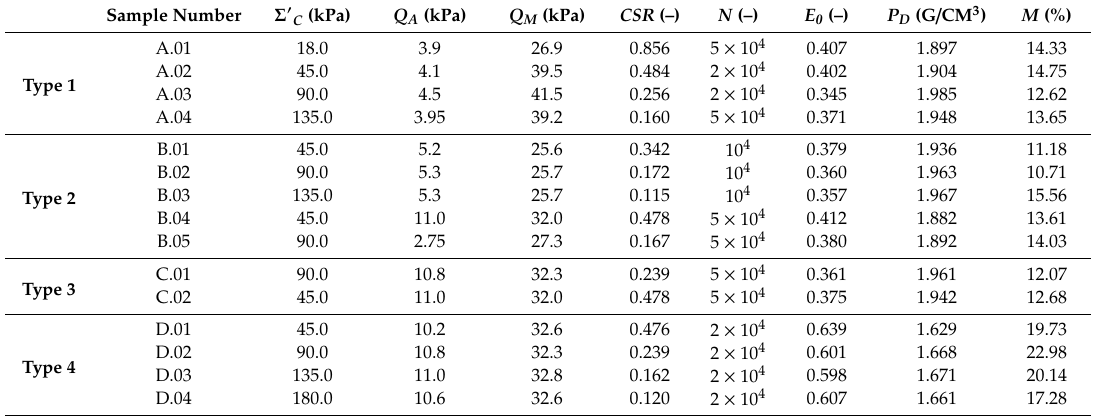
Table 2. Cyclic triaxial loading program of cohesive materials.